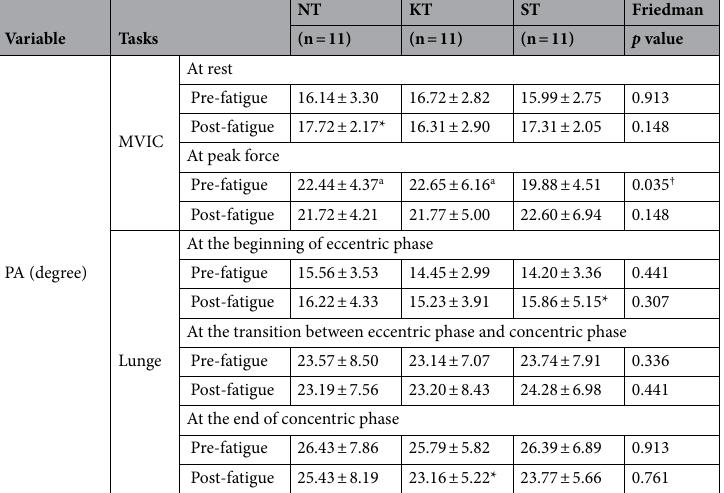
Table 3. Pennation angle of medial gastrocnemius muscle. Data are presented as means + SD. NT, no taping; KT, kinesio taping; ST, sham taping; SD, standard deviation; MVIC, maximum voluntary isometric contraction. *Statistically significant difference pre- and post-fatigue (Wilcoxon signed-rank test, p < 0.05). † Statistically significant difference between NT, KT and ST groups (Friedman test, p < 0.05). a Statistically significant difference to the ST group (Wilcoxon signed-rank test, p < 0.05).